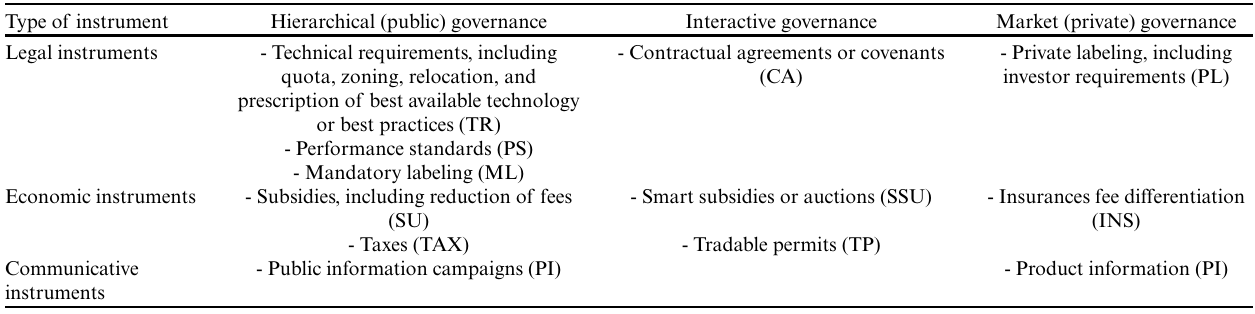
Table 1. A list of promising policy instruments for promoting adaptation to climate